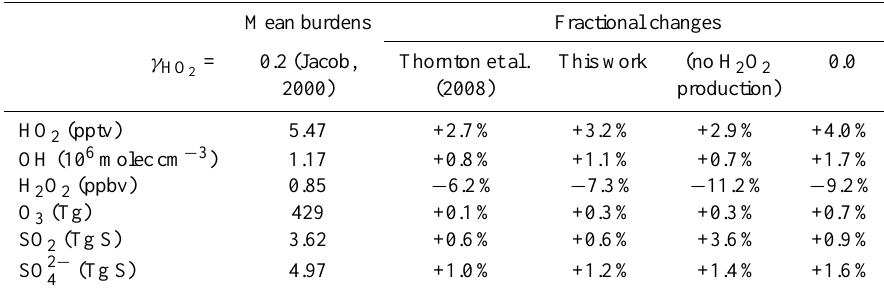
Fig. 2. Surface and zonal mean HO 2 reaction probabilities ( γ HO model using the parameterisation in Table 1. Table 2. Impact on global annual mean tropospheric burdens and concentrations of oxidants and sulfur species of different uptake schemes expressed as a fractional change as compared to γ HO Table